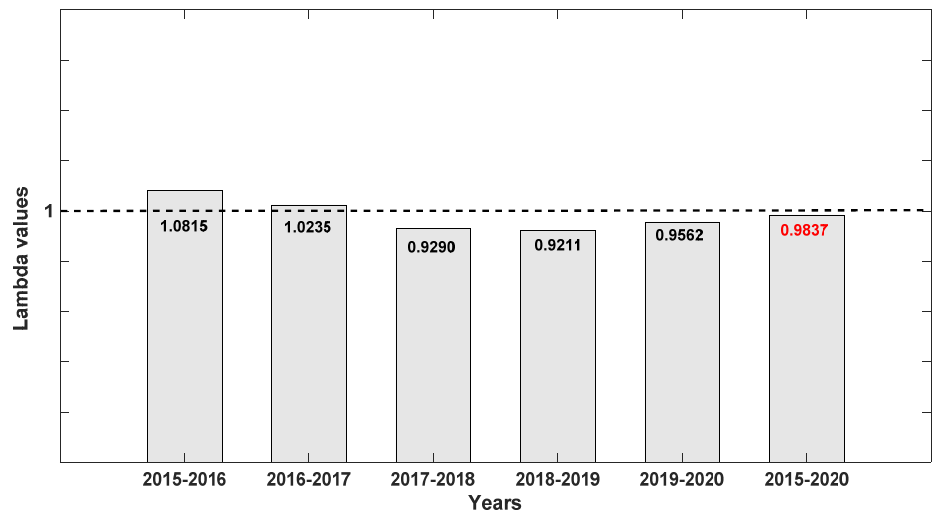
Figure 4. Lambda ( λ ) values for each pair of years for Dendrophylax lindenii in Population A. Note that these values are slightly higher for all six years except the second pair year (2016–2017), suggesting that Population A is most stable for now possibly because it harbored a high number of seedlings.